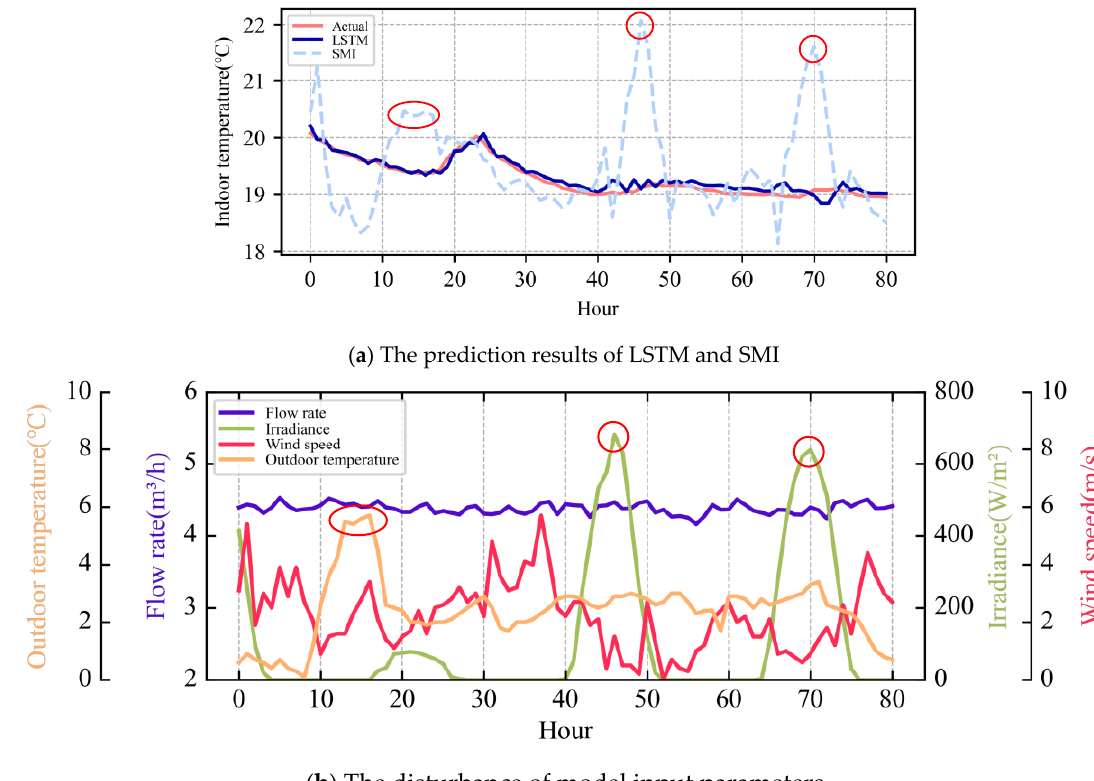
Figure 9. Comparison between LSTM and SMI in building A.